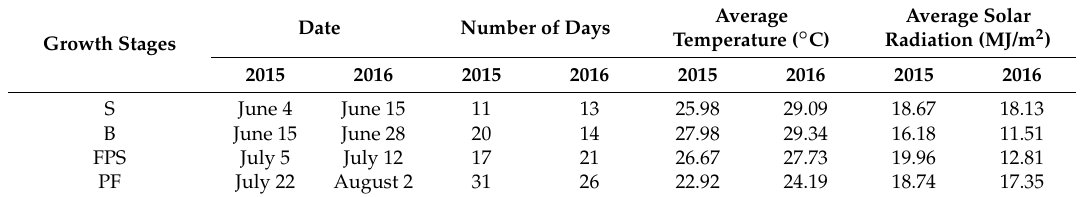
Table 2. Soybean growth stages and average temperature during each growth period.